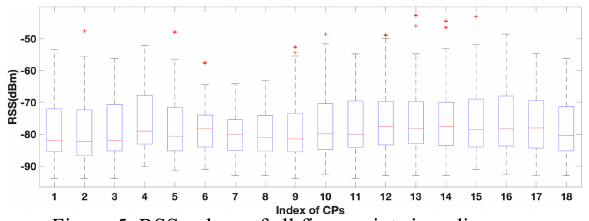
Figure 5. RSS values of all fingerprints in radio